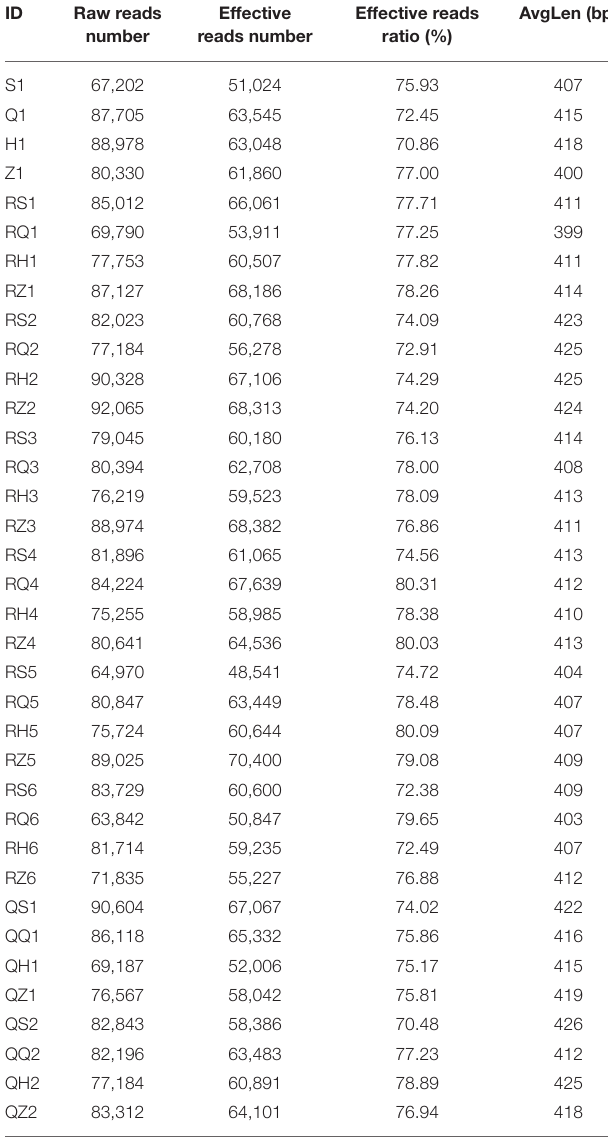
TABLE 2 | Statistics the data of the samples